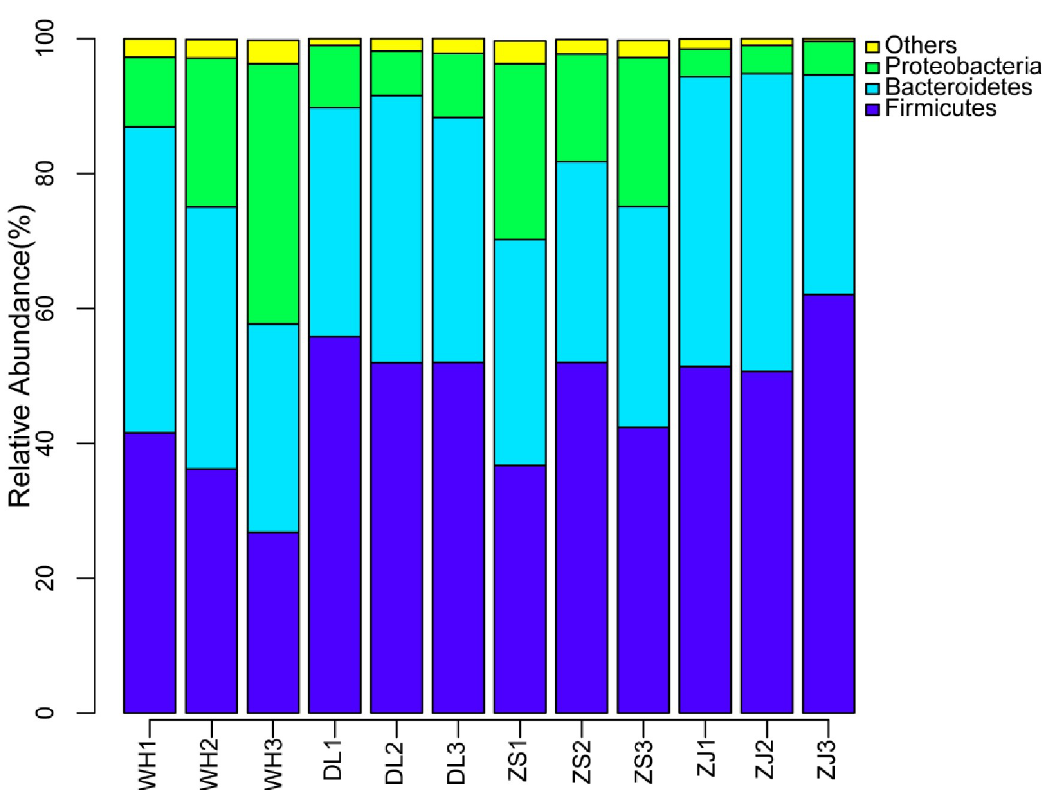
Fig 4. Relative abundance of different bacterial phyla of the RPMs from four coastal locations in